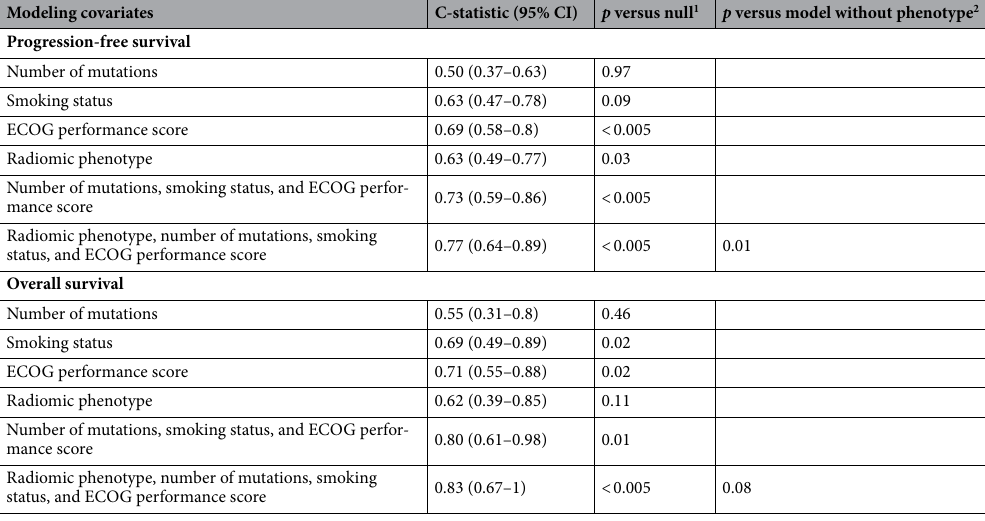
Table 4. Predictive ability of Cox regression models for progression-free and overall survival. 1 p value by likelihood ratio test versus the hypothesis that the model is no better than the null model, in which all patients are at equal risk. 2 p value by likelihood ratio test versus the hypothesis that the model is no better than the same model without radiomic